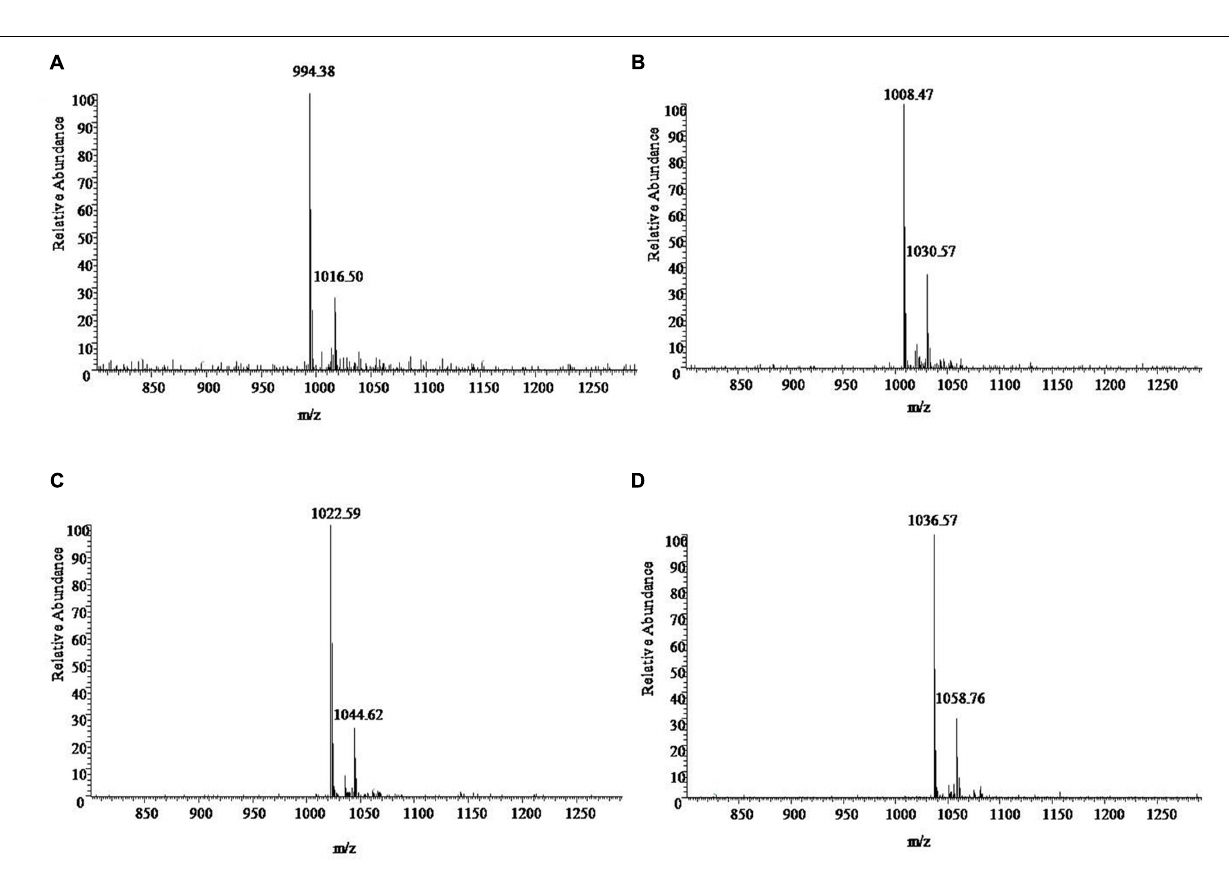
Frontiers in Microbiology |